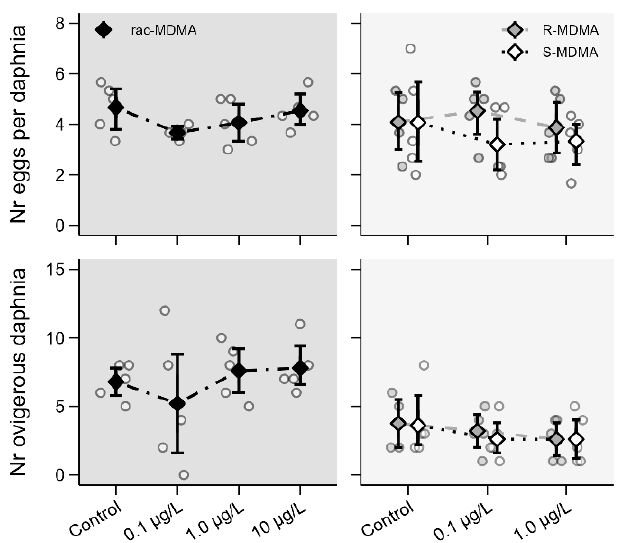
Figure 6. Reproductive effects of ( R,S )-MDMA ( left ; dark grey panels) and its enantiomers ( right ; light grey panels) determined on day 8 in Daphnia magna . Data are presented as individual observations (circles), mean values (diamonds) and 95% bootstrap confidence intervals (error bars).